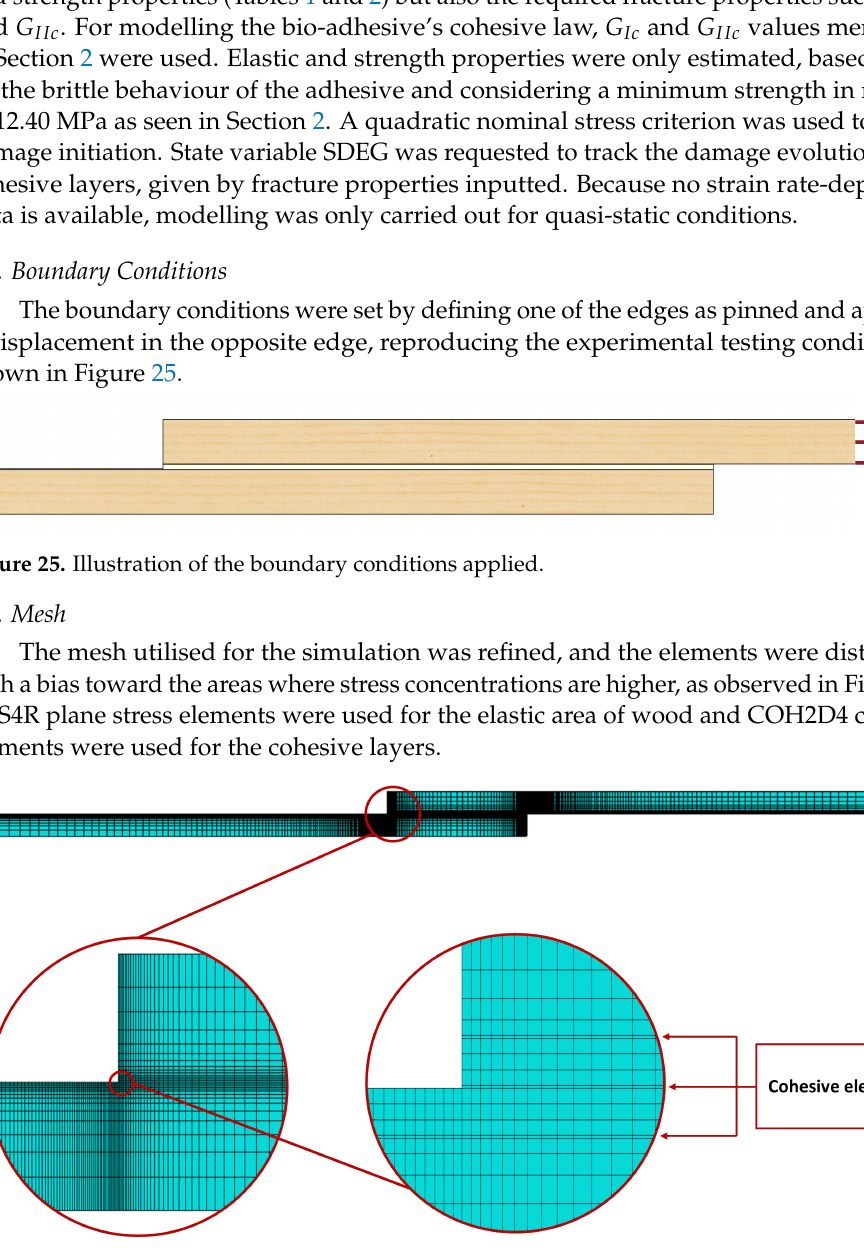
Figure 26. Mesh used in the